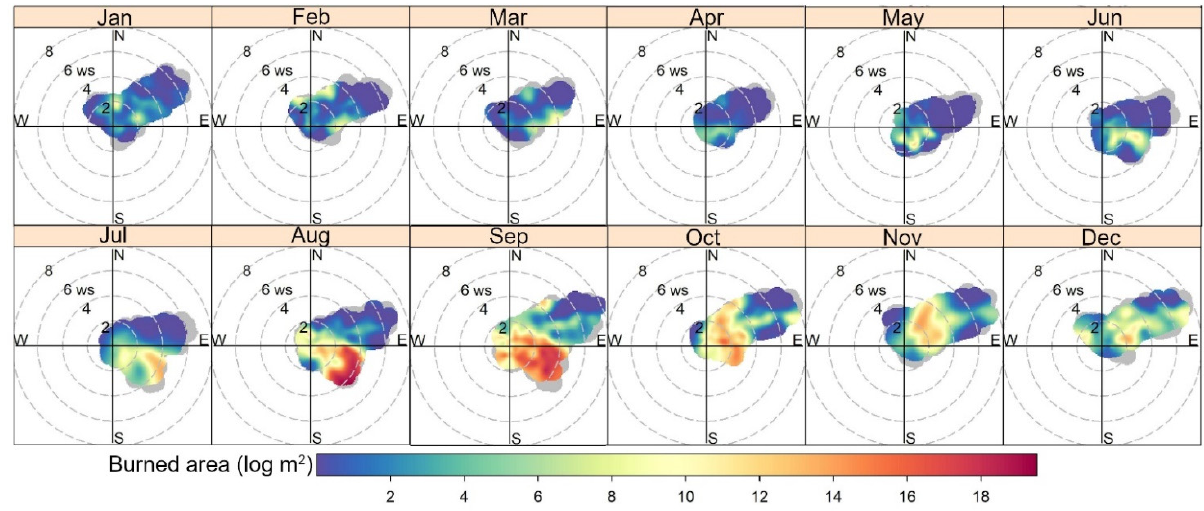
Figure 4. Monthly variation in mean values of burned area (log) considering the predominant wind speed (ws) and meteorological direction for the BLA region. Table 3. Correlation between the instrumental variables and the explanatory variable. LogBA BaWSpeed BaWDirec AOD 0.0023 ns − 0.0672 *** − 0.0644